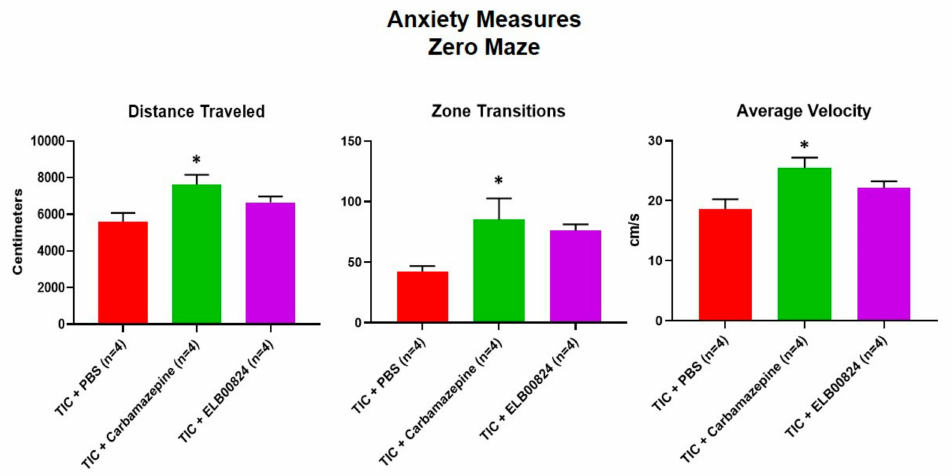
Figure 5. E ffi cacy of ELB0824 was less than that of carbamazepine with zero maze anxiety testing. The testing of ELB00824 was done in mice with TIC chronic neuropathic pain persisting 6 weeks. The asterisks (*) indicate p < 0.05 compared to TIC with vehicle ( n = 4)